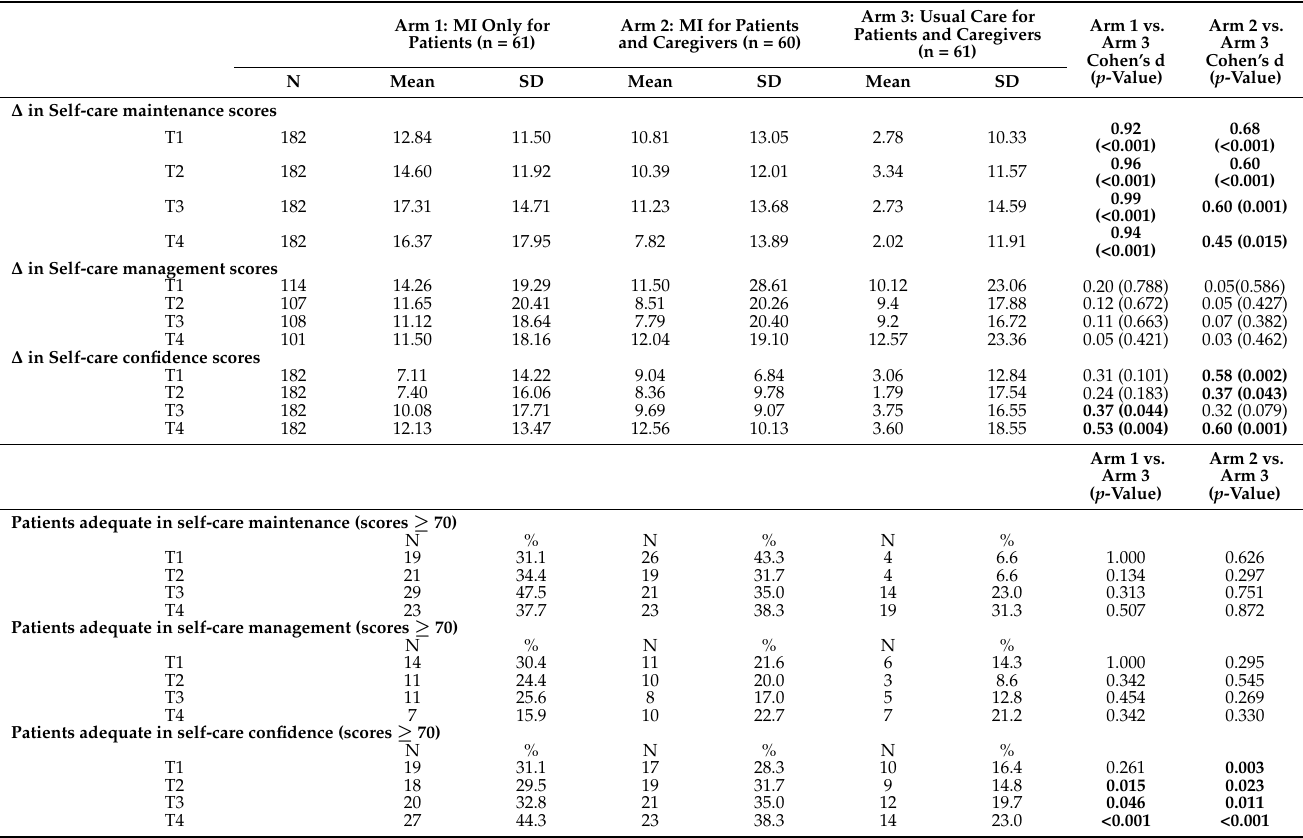
Table 2. Self-care changes and frequencies of patients adequate in self-care during follow-up, and comparisons between experimental arms (arms 1 and 2) and control